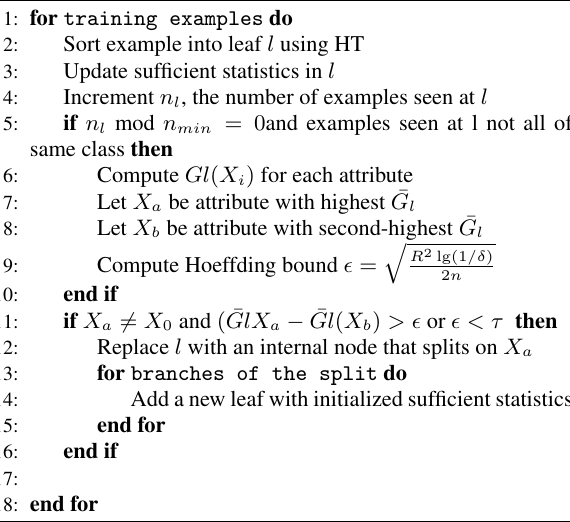
Algorithm 2 Hoeffding tree induction algorithm